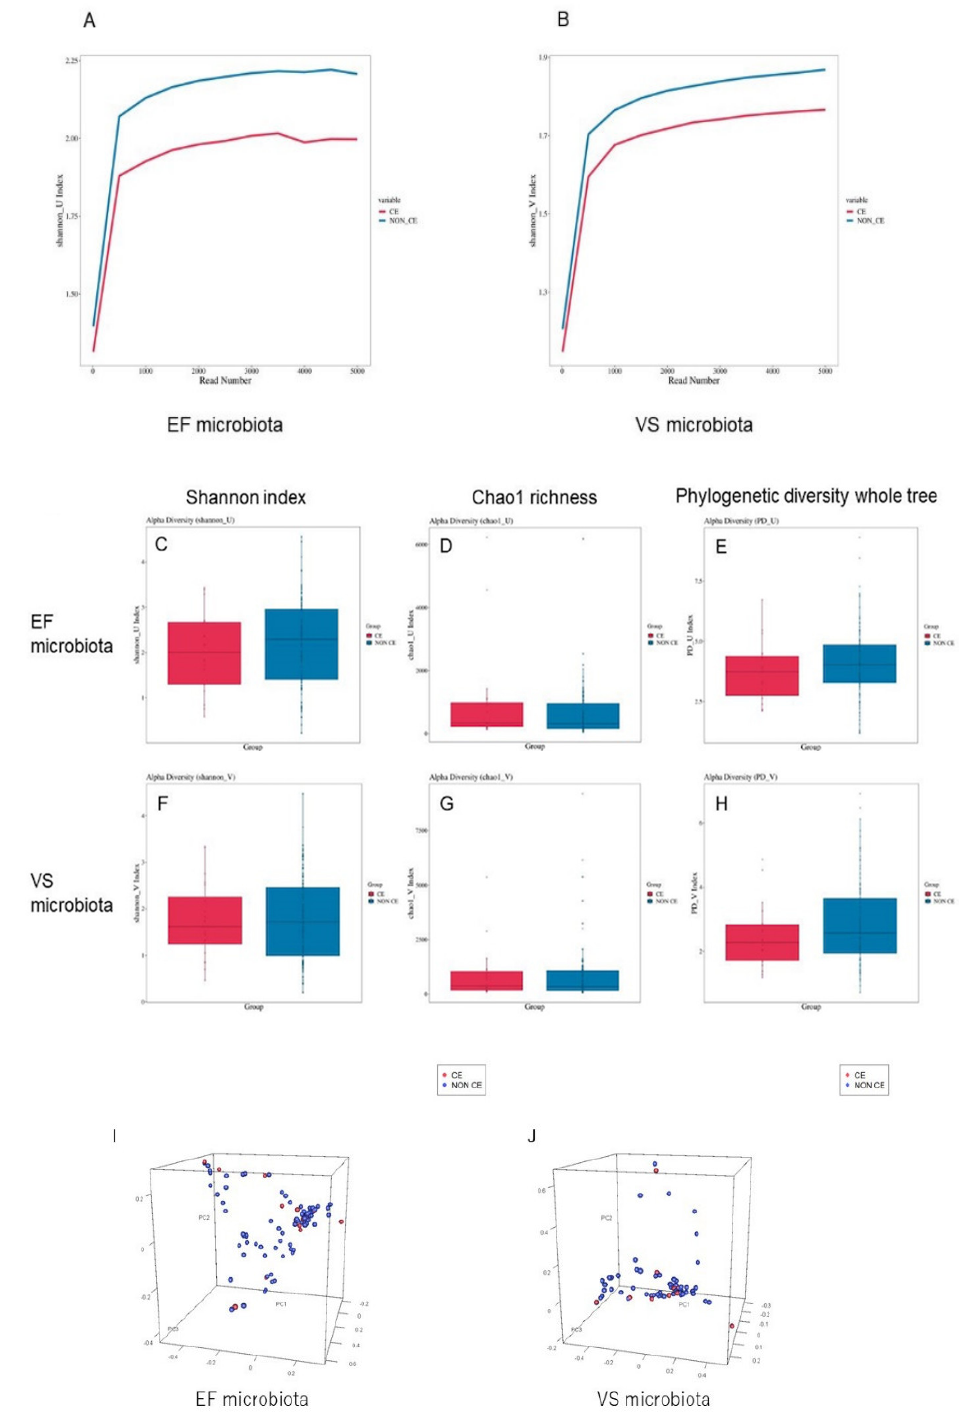
Figure 1. α - and β -Diversity values for comparison of bacterial communities in EF and VS in the CE and non-CE group. Rarefaction analysis of sequences per sample for Shannon index in EF ( A ) and VS ( B ) in CE (red lines) and non-CE (blue lines) cases. Comparison of Shannon index ( C , F ), Chao1 richness ( D , G ), and phylogenetic diversity whole tree ( E , H ) of EF ( C – E ) and VS ( F – H ) microbiota in the CE (red column) and non-CE (blue column). Each graph represents mean (column) and SE (bars). Principal coordinate analysis plotting for β -diversity of EF ( I ) and VS ( J ) microbiota in CE (red dots) and non-CE (blue dots) generated using UniFrac distance metrics.